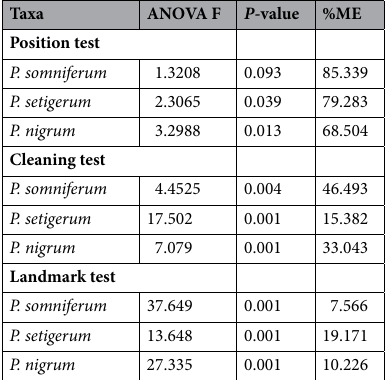
Table 1. Results of the reproducibility tests (seed positioning, photography cleaning and landmarking) performed through Anova: F: Fisher statistics, P -value and measuring error (%) when comparing the three taxa of P. somniferum